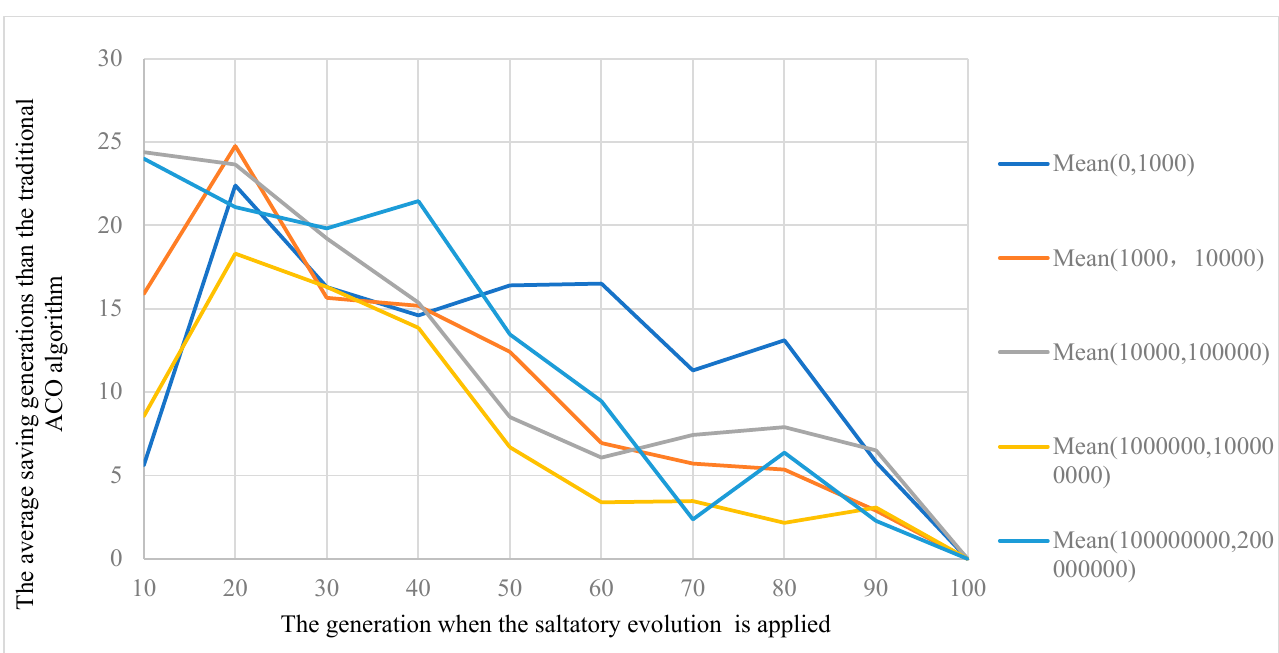
Figure 11. The classified statistics of path distance dispersion.